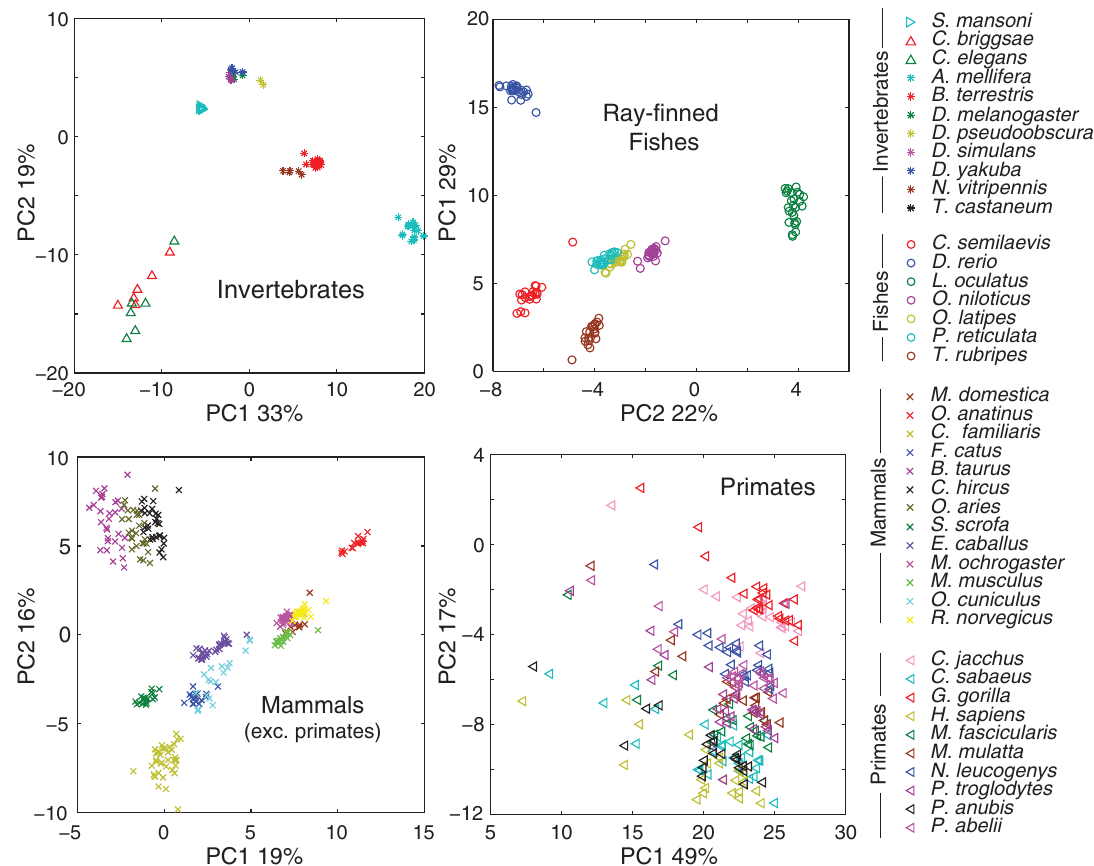
FIG. 3. Cross-species comparison of intron word frequencies using principle components analysis (PCA). Each point in the PCA plots corresponds to a single chromosome projected on the two principal axes. Principal axes are computed using the 6-mer relative word frequency vectors (2-mer null model) of all chromosomes shown in each plot. See Table S3 of Ref. [32] for further species